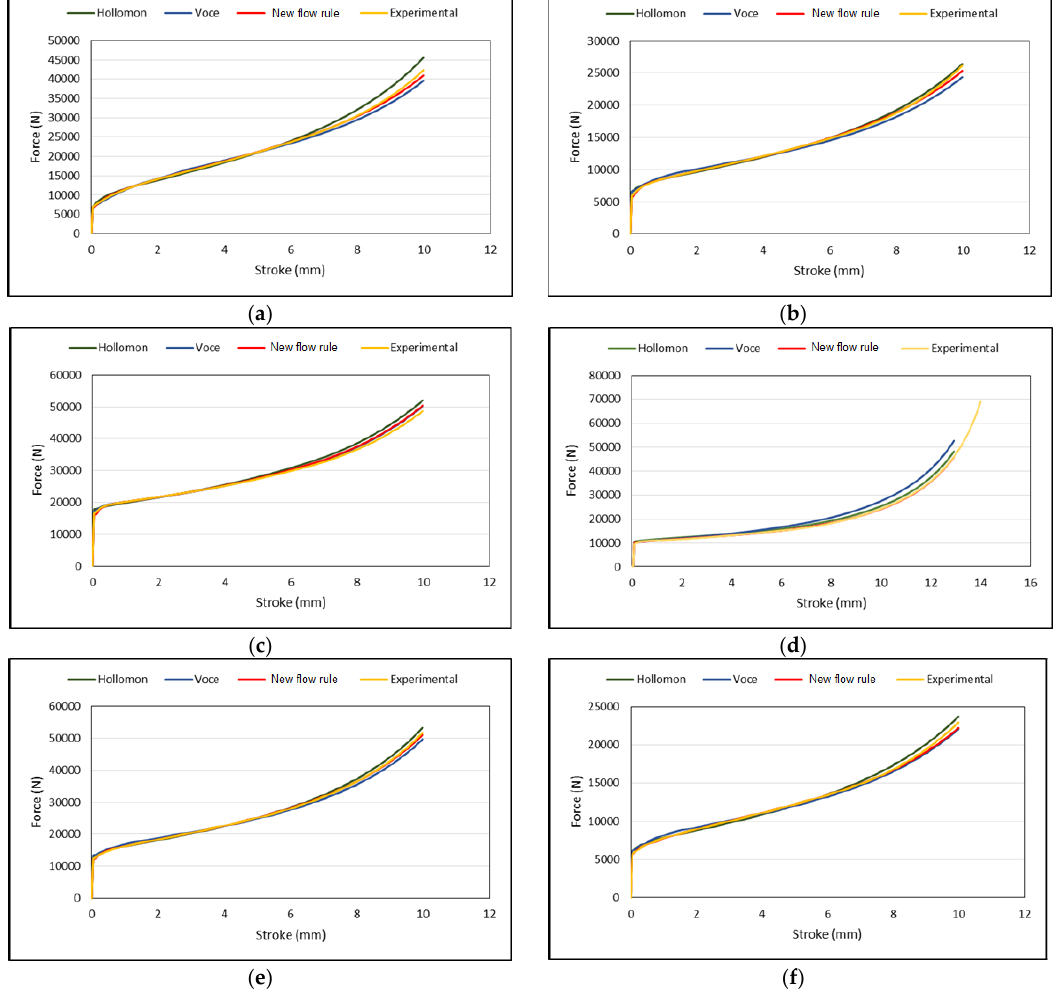
Figure 16. Load-stroke curves obtained by FEM for AA5754 at the three starting states: ( a ) AA5754 N0 25 °C; ( b ) AA5754 N0 250 °C; ( c ) AA5754 N2 25 °C; ( d ) AA5754 N2 250 °C; ( e ) AA5754 N2 + flash 25 °C; ( f ) AA5754 N2 + flash 250 °C.